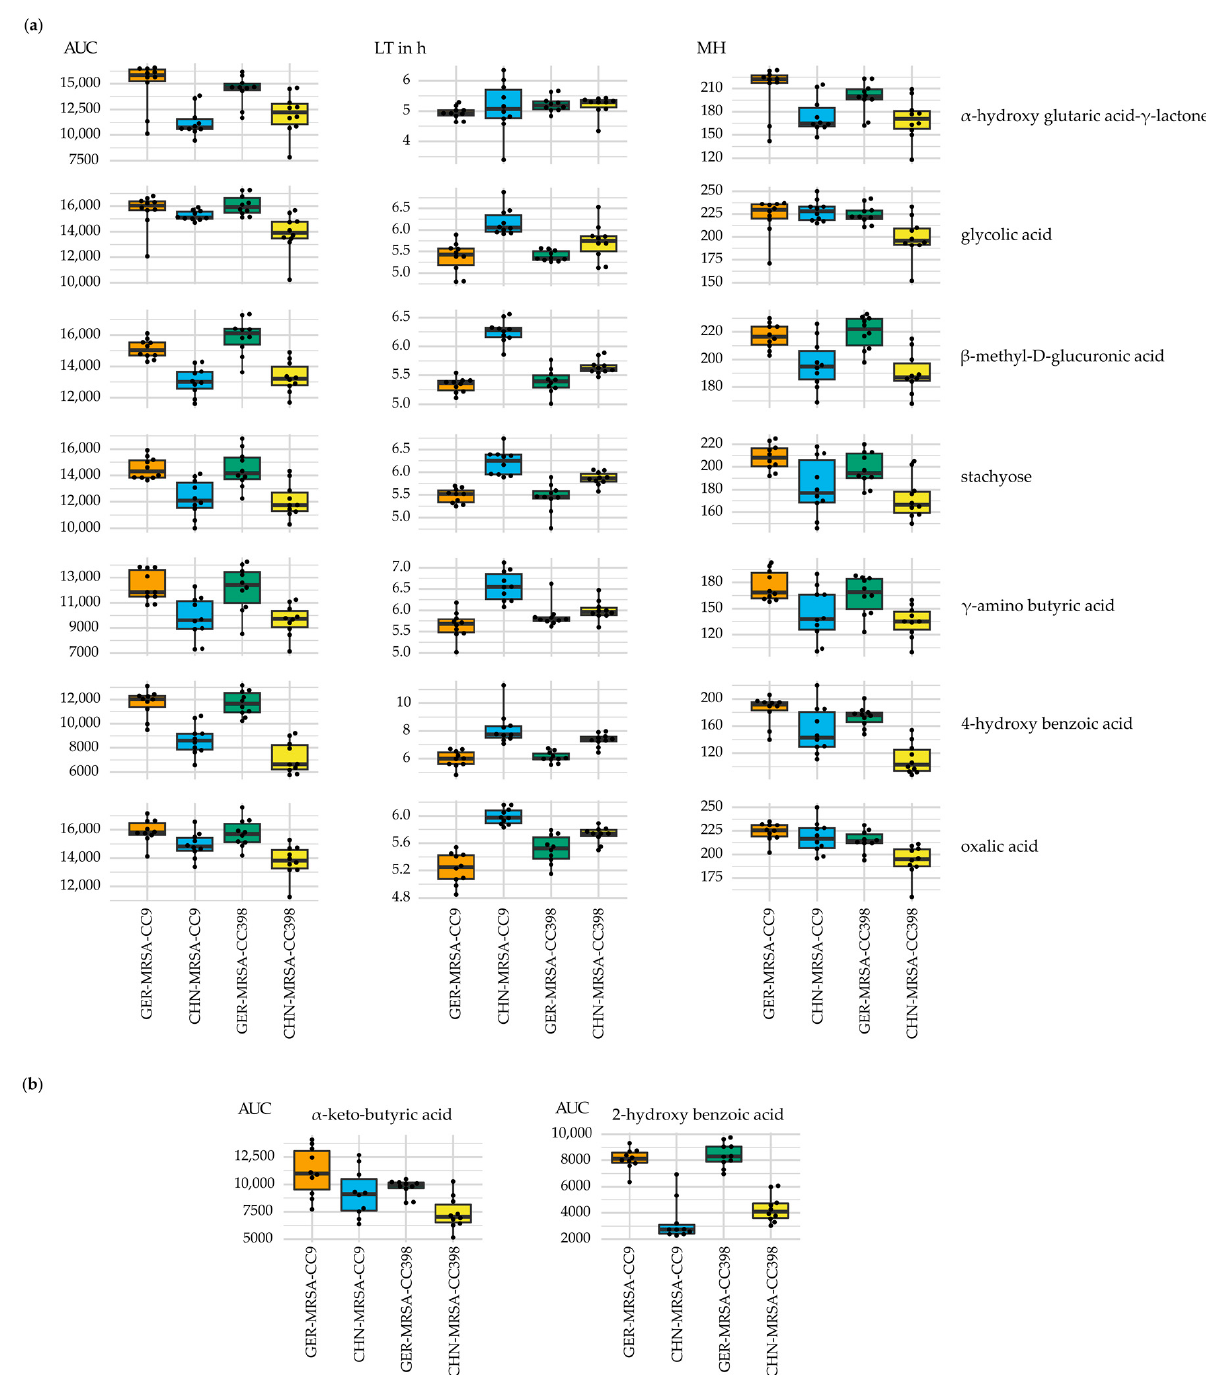
Figure 7. Metabolic differences associated with the isolates’ origin. The box plots illustrate varying ( a ) area under the curve (AUC), lag time (LT) and maximum height (MH) values of the four isolate groups regarding the usage of the nutrients given on the right hand side of the individual diagrams with the LT given in hours and ( b ) AUC values of the four isolate groups regarding the usage of α -keto-butyric acid and 2-hydroxy benzoic